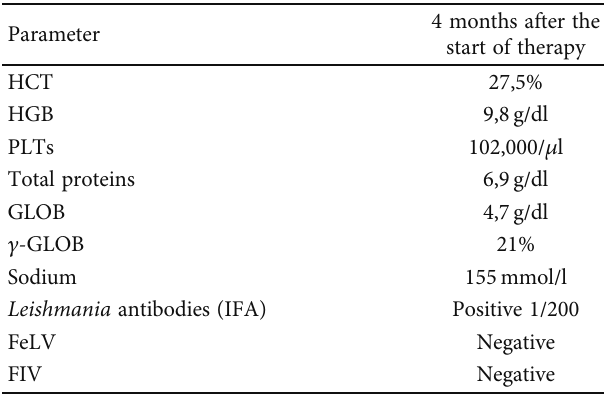
Figure 6: Four months after the start of therapy, the cat looks normal. Table 2: Clinical pathology results after